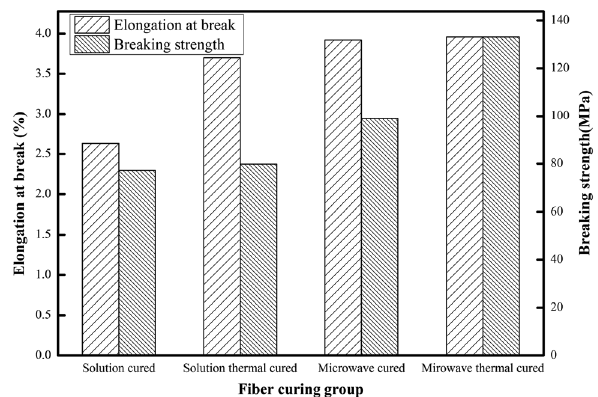
Figure 9: Comparison of elongation at break and strength of phe - nolic epoxy fi bers after SC, MC, STC, and